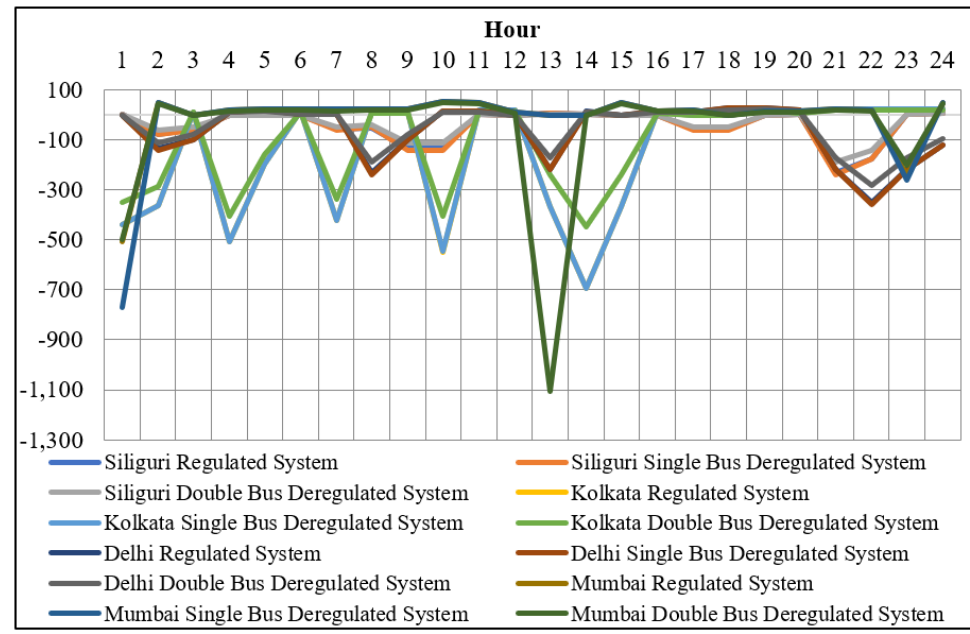
Figure 11. Imbalance cost ($/h) analysis during 24 h in different cities.